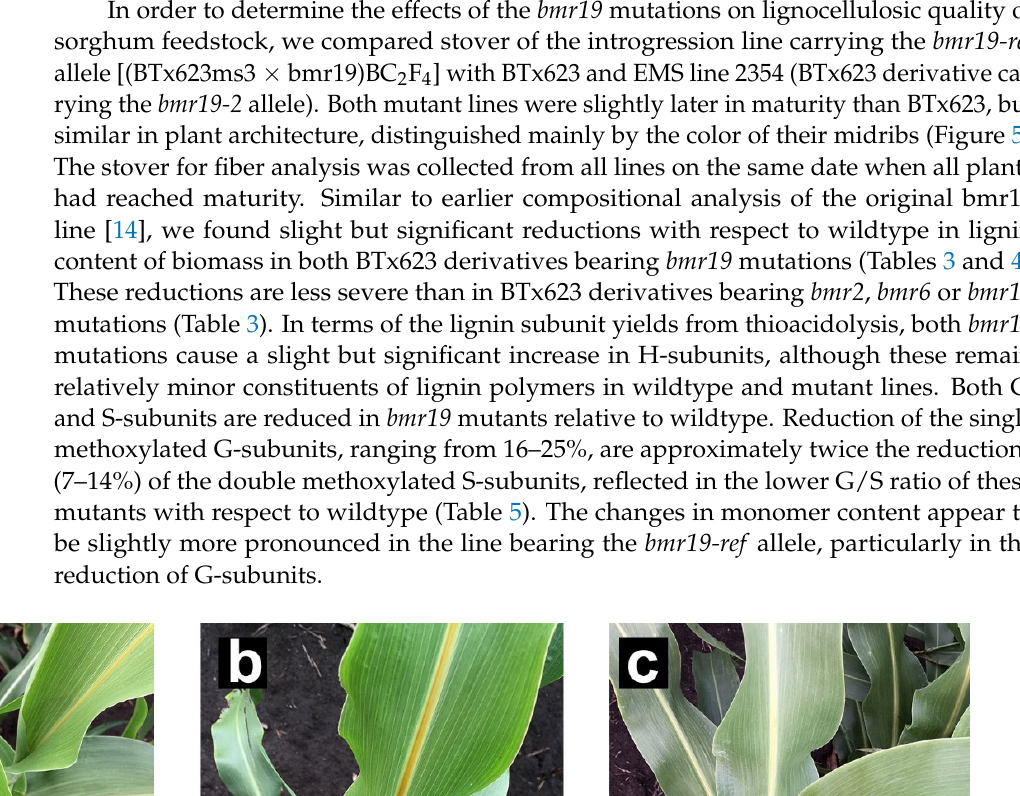
Table 5. Lignin monomer [ p -hydroxyphenyl (H), syringyl (S), guaiacyl (G)] yield by thioacidolysis of field grown biomass from BTx623 and derivatives.